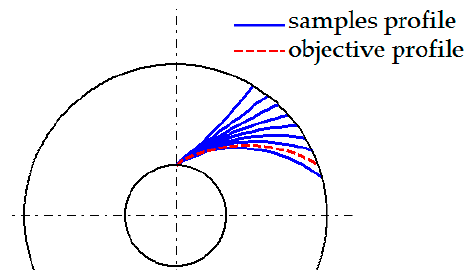
Figure 5. Schematic diagram of blades profile.